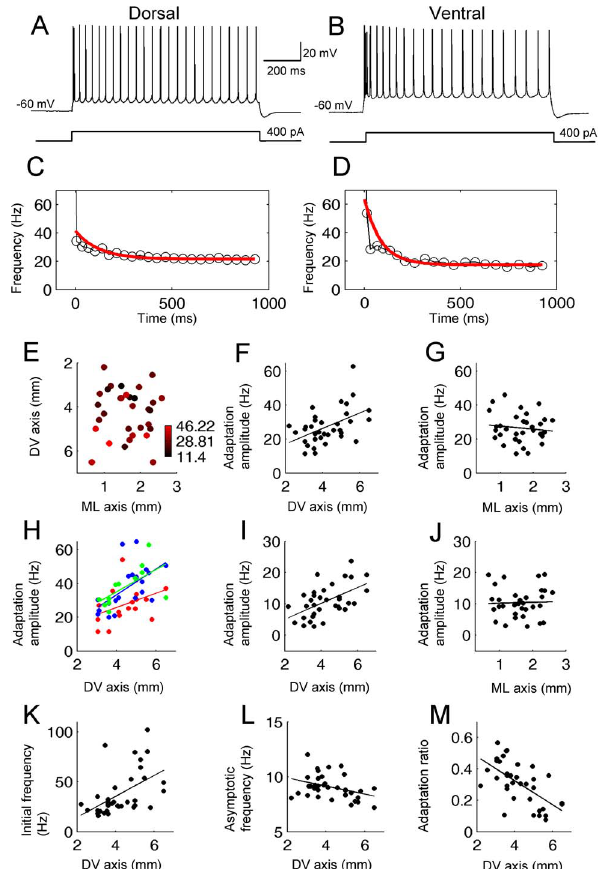
Figure 2. Spike frequency adaptation is greater in ventral cells in normal ACSF. (A and B) Train of action potentials elicited in a dorsal (A) and ventral (B) neuron during 1 s pulse injection. (C and D) Instantaneous frequency of neuron in A and B, respectively (black). The red line shows the single exponential fit. (E) Color plot of the adaptation amplitude (see Methods) at different locations in the two-dimensions (DV and ML) of anatomical space. Note many red dots in ventral and many black dots in dorsal locations indicating greater adaptation in ventral cells. (F and G) Adaptation amplitude plotted along the DV and ML axis, respectively. (H) Adaptation amplitude with 300 (red), 400 (green), and 500 pA (blue) current injection. (I and J) Adaptation amplitude without the first two spikes along the DV and ML axis, respectively. (K) Initial firing frequency plotted against the DV axis. (L) Asymptotic firing frequency plotted against the DV axis. (M) Adaptation ratio calculated from the initial and asymptotic frequency. Note smaller adaptation ratio in ventral cells which indicates stronger adaptation.